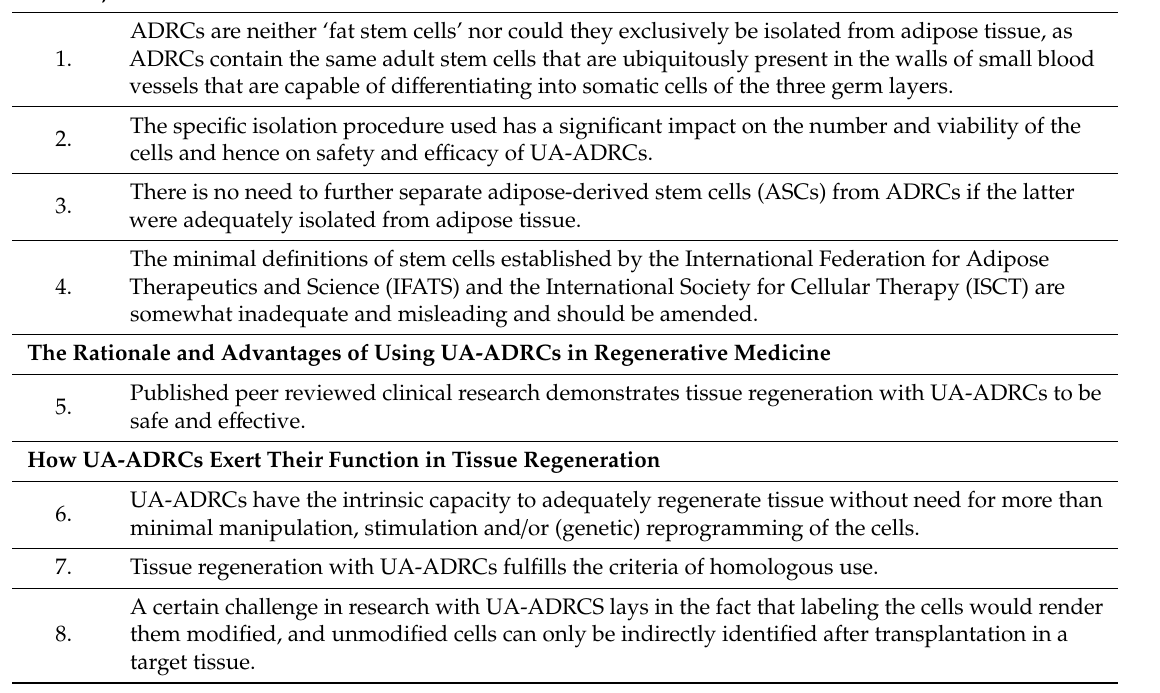
Table 1. Eight statements about uncultured, autologous, fresh, unmodified, adipose derived regenerative cells (UA-ADRCs) and their application in regenerative medicine, reflecting the current state of knowledge in the